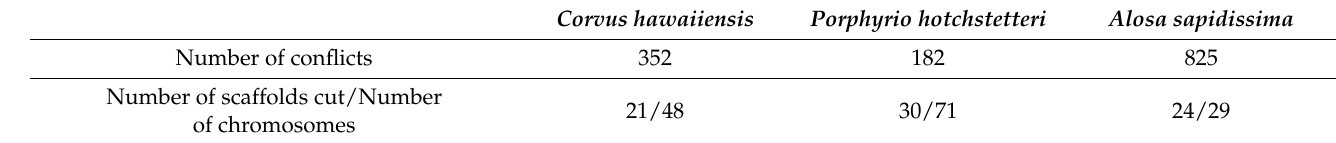
Table 4. Classification of conflicts between optical maps and Hi-C scaffolds based on the manual evaluation of incongruent regions. The table shows the total number of conflicts identified by alignment to optical maps and the number of affected scaffolds compared to the total number of chromosomes. Corvus hawaiiensis Porphyrio hotchstetteri Alosa sapidissima Number of conflicts 352 182 825